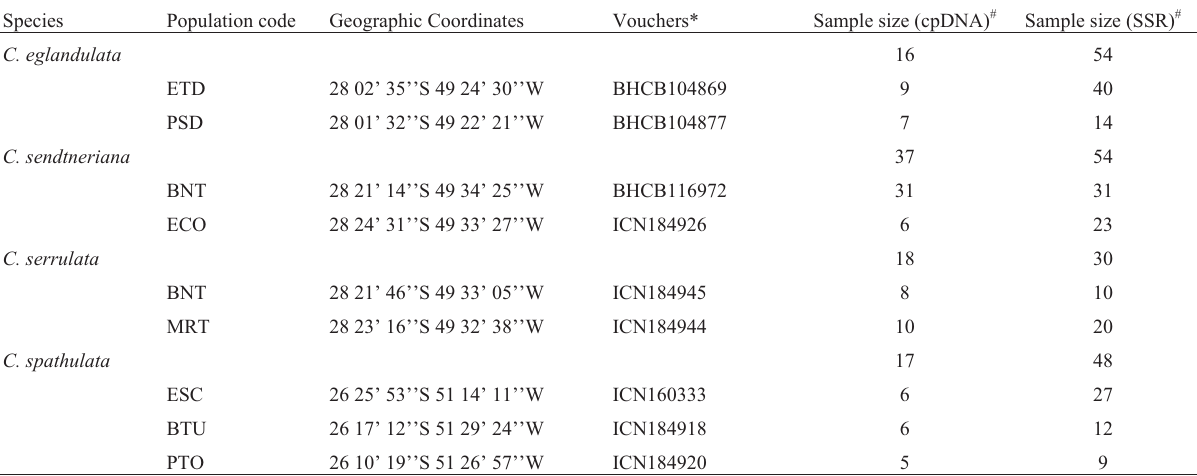
Table 1 - Sampling information for four Calibrachoa